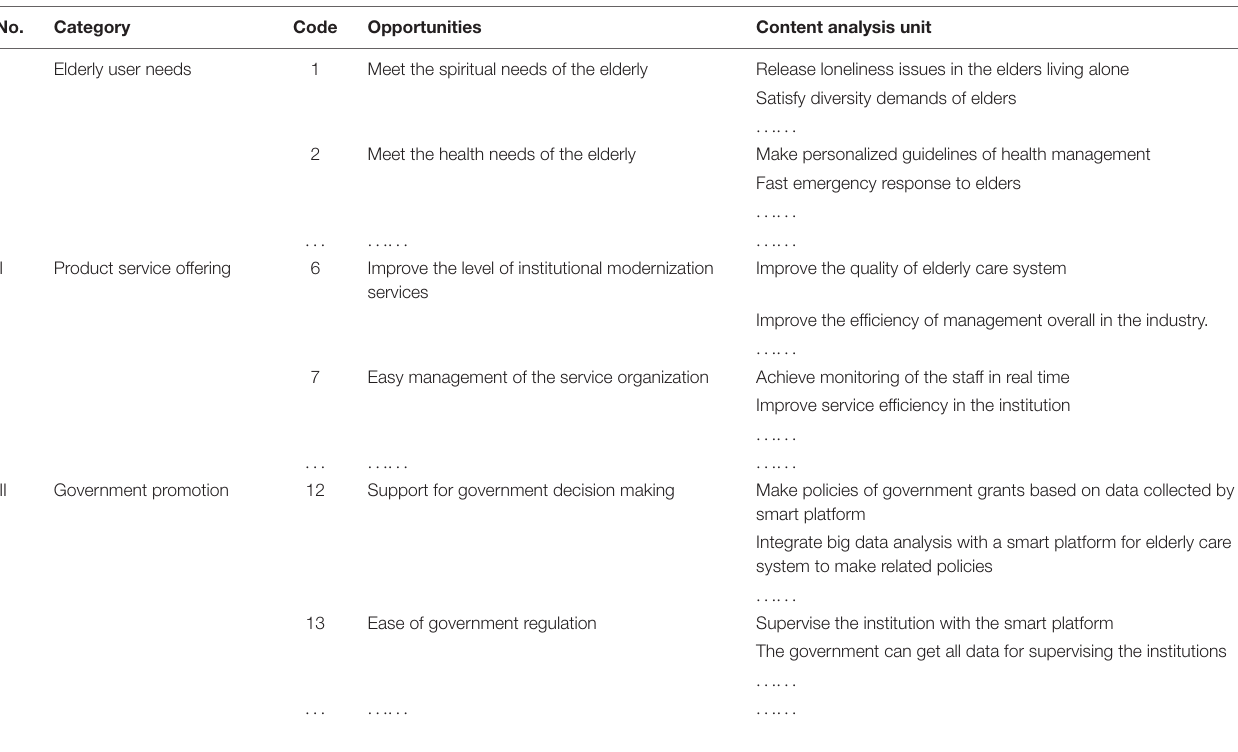
TABLE 2 | The content analysis coding table of opportunities in the